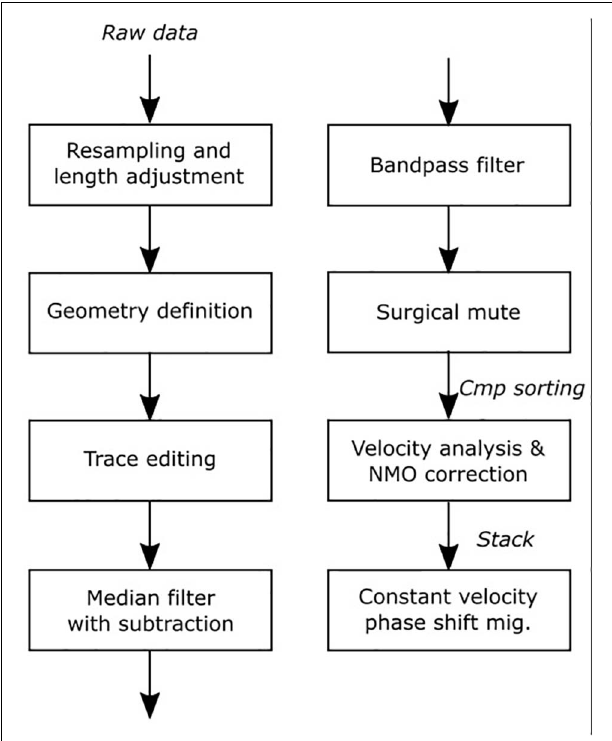
FIGURE 7 | Seismic processing flow applied to the SO profile to enhance the reflections within the water column and in particular the shallow part of the